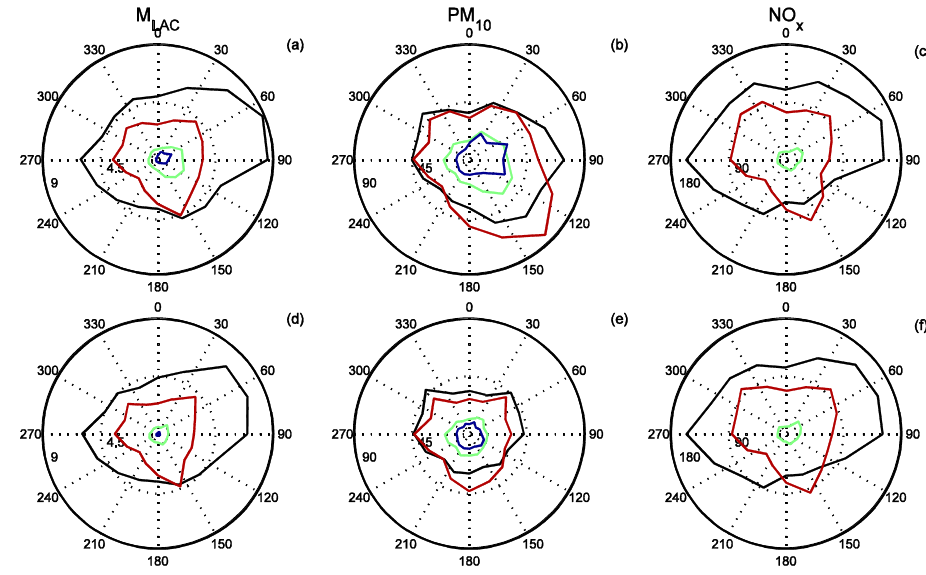
Fig. 7 Fig. 7. Rose plots of pollutant concentrations (M LAC , PM 10 , and NO x ) based on hourly measurements at the four sites and expressed as µgm − 3 . Top panel (a–c) : whole period 20 April–5 July 2006. Bottom panel (d–f) : measurements in the period 24‘April–9 May 2006 were excluded (LRT event). Color code: Hornsgatan (black), Essingeleden (red), Torkel (green), and Aspvreten